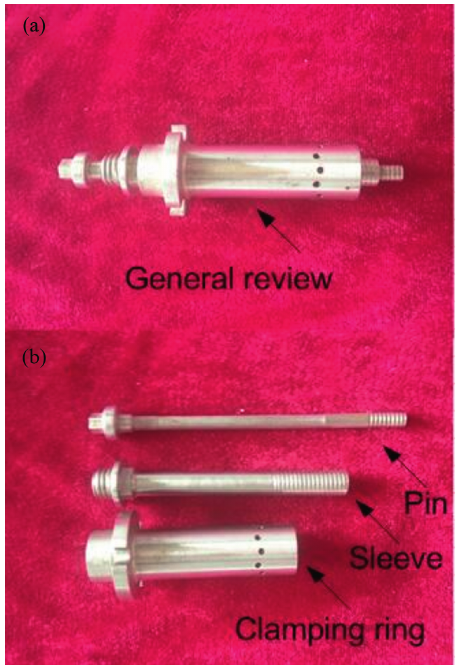
Figure 4: Tool used in the experiment: (a) general view and (b) detailed